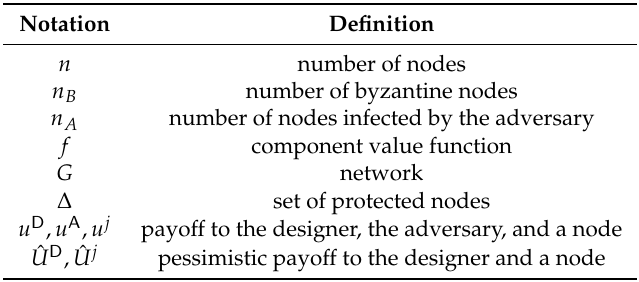
Table 1. Summary of the